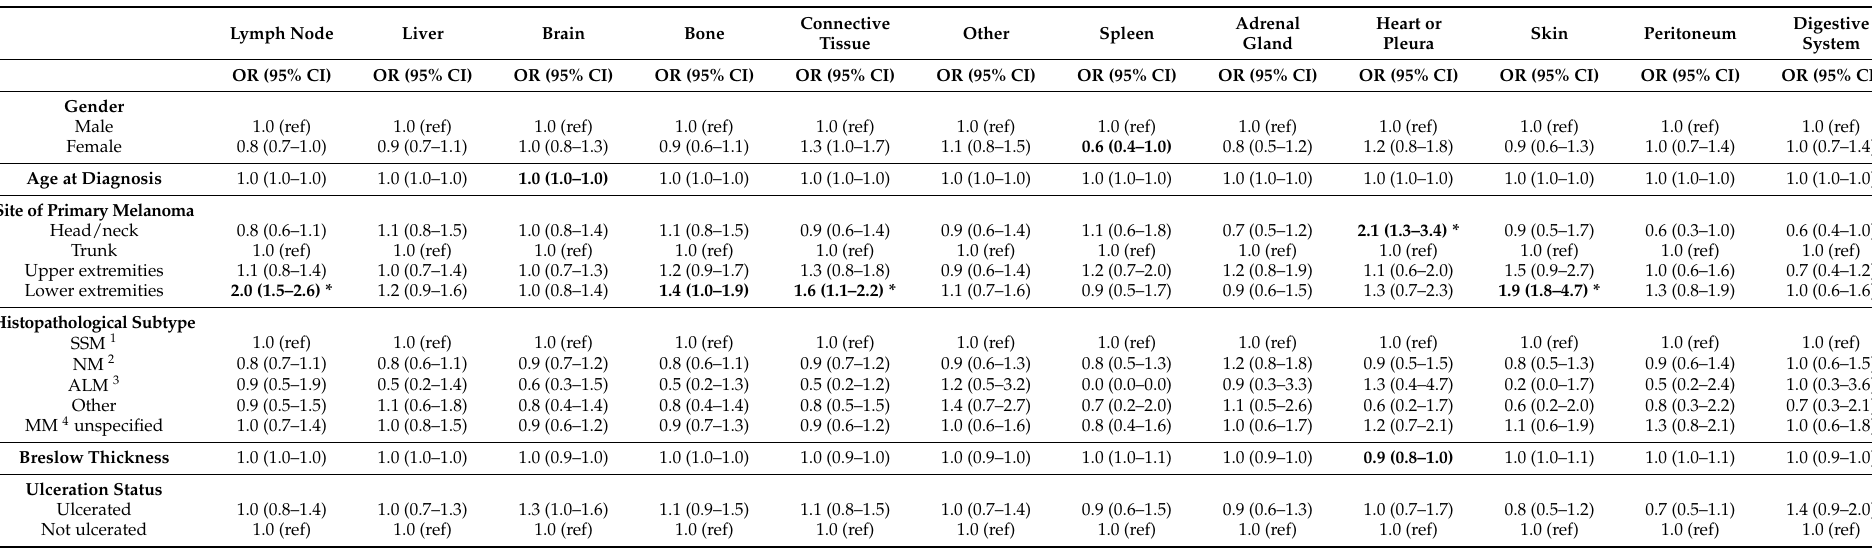
Table 6. The localisation of distant metastases in relation to patient and tumour characteristics in a multivariable model with the lungs as the reference metastatic